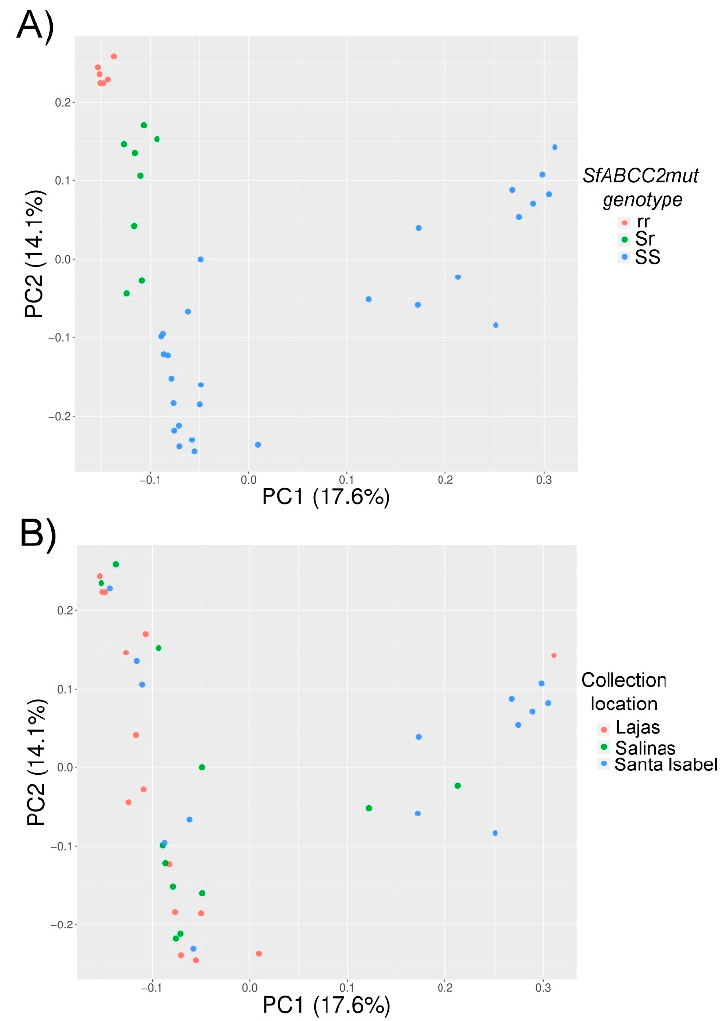
Figure 3. PCA projection plot of 1333 bi-allelic variants found within SfABCC2 of 41 S. frugiperda samples and colored based on genotype for SfABCC2mut ( A ) and location ( B ). The SfABCC2mut genotype was determined as described in the Methods.